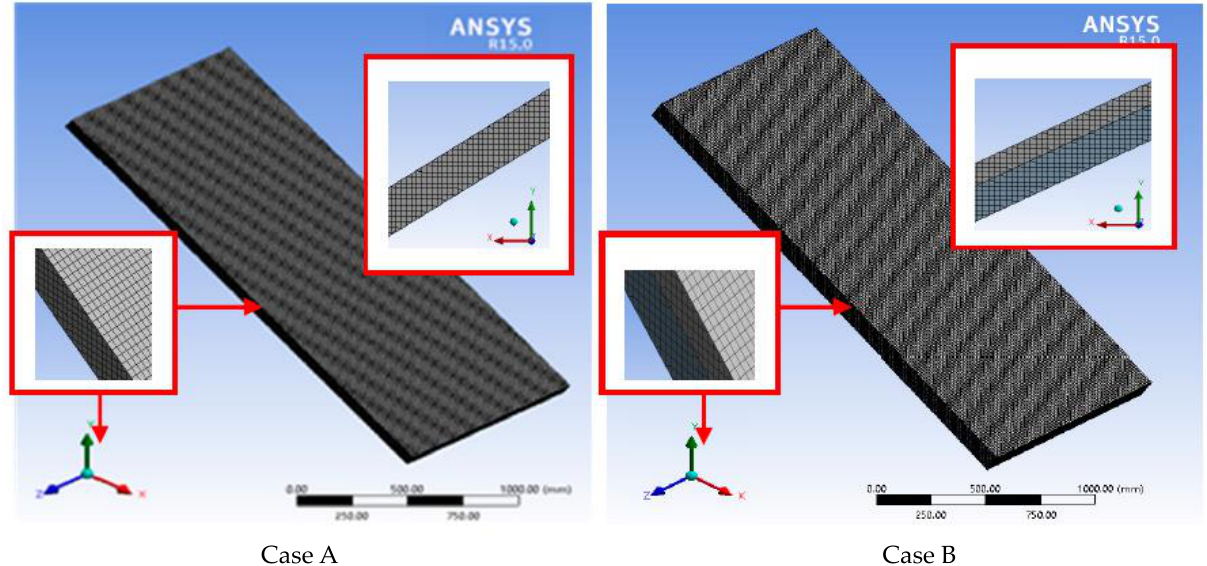
Figure 5. Meshed CFD domain for the two tested FPSAHs.